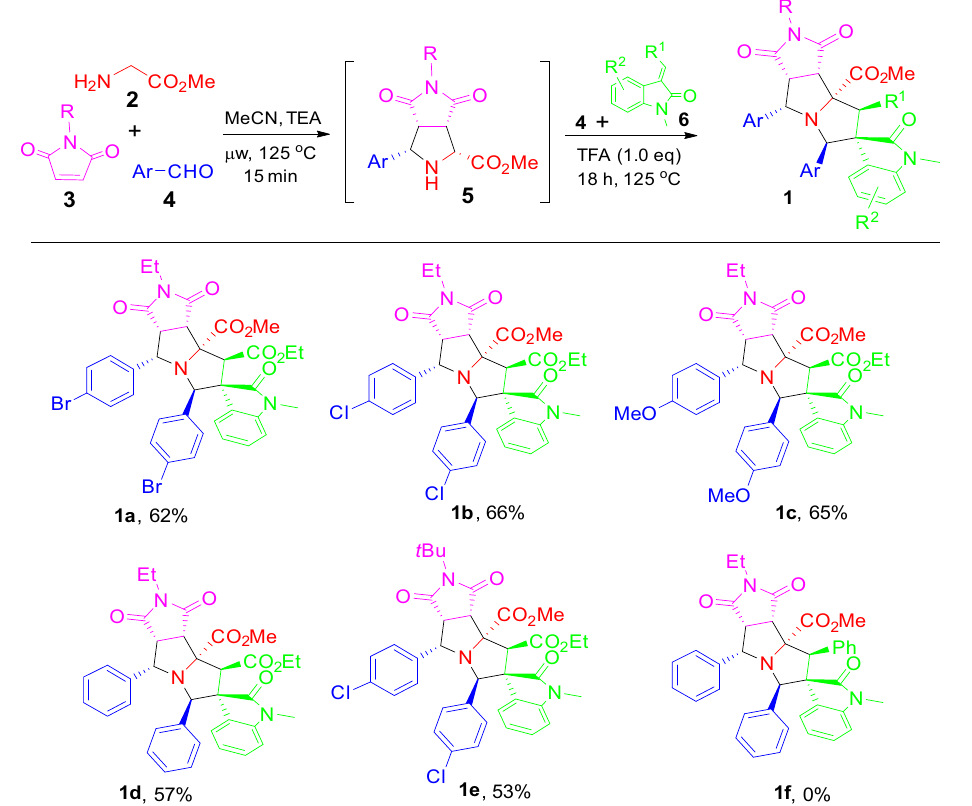
Figure 2: Double [ 3 + 2 ] cycloadditions using two equivalents of same aldehyde 4 . Isolated yield: reaction conditions are same as in Table 1, entry